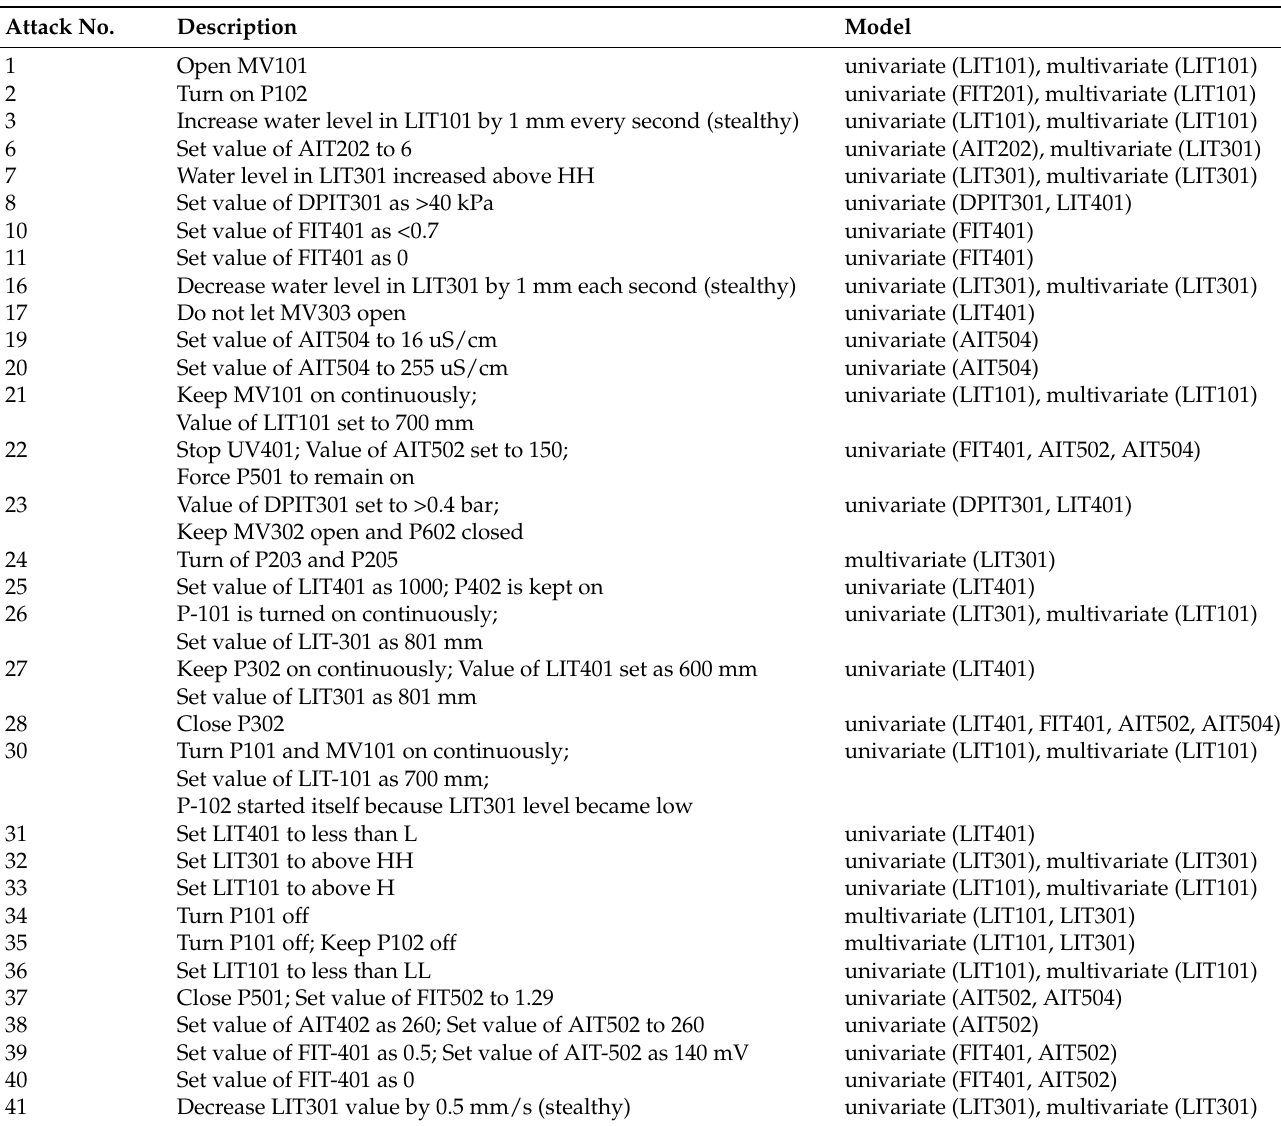
Table 3. Overview of all 32 detected attack scenarios injected in the SWaT testbed [54]. Sensor type in parenthesis denotes the corresponding CNN-based